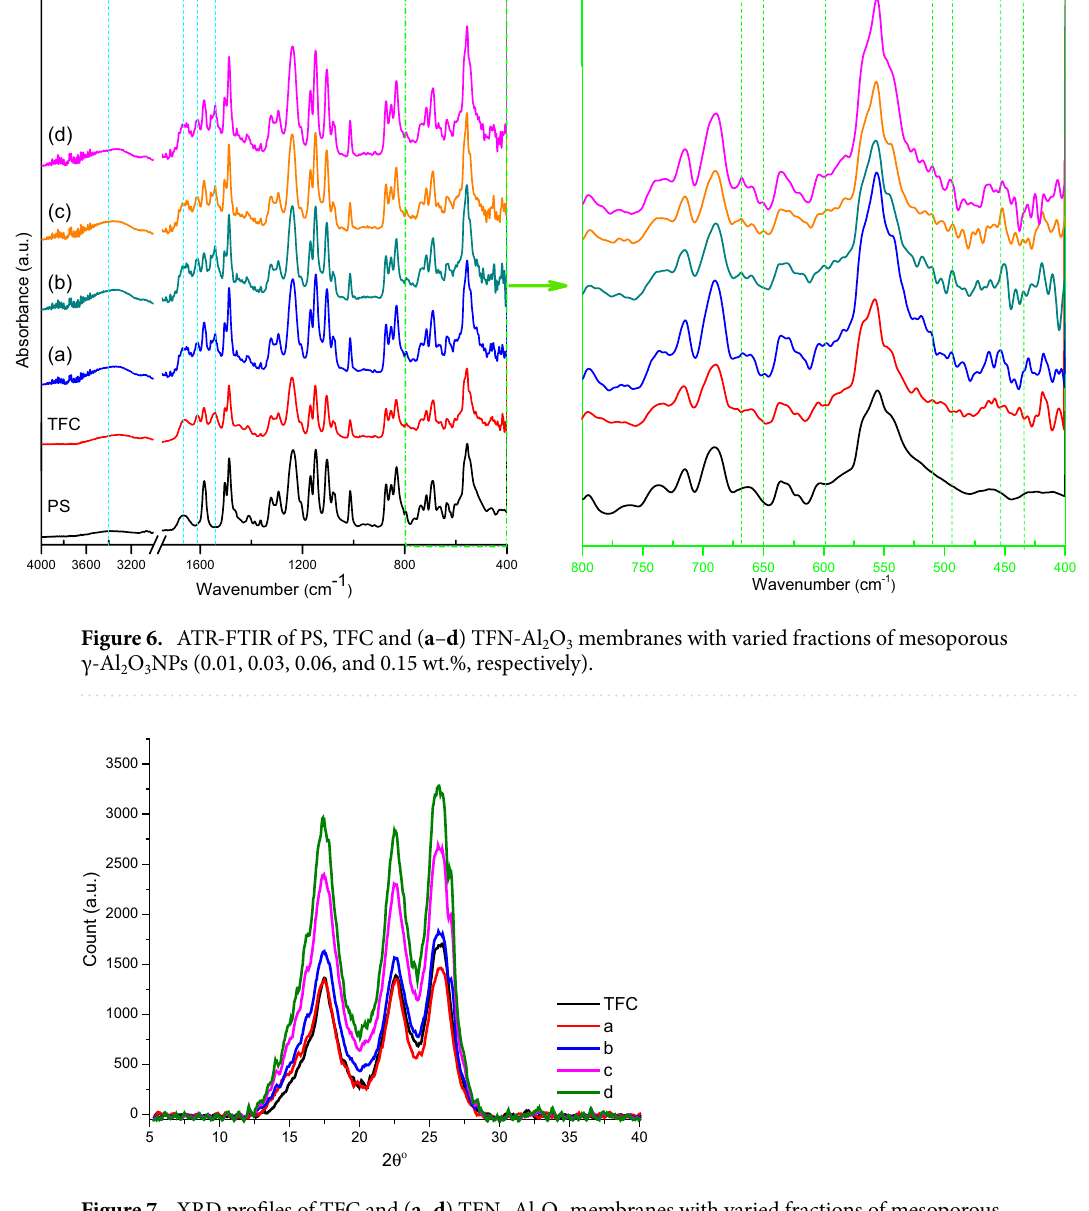
Figure 7. XRD profiles of TFC and ( a – d ) TFN- Al 2 O 3 membranes with varied fractions of mesoporous